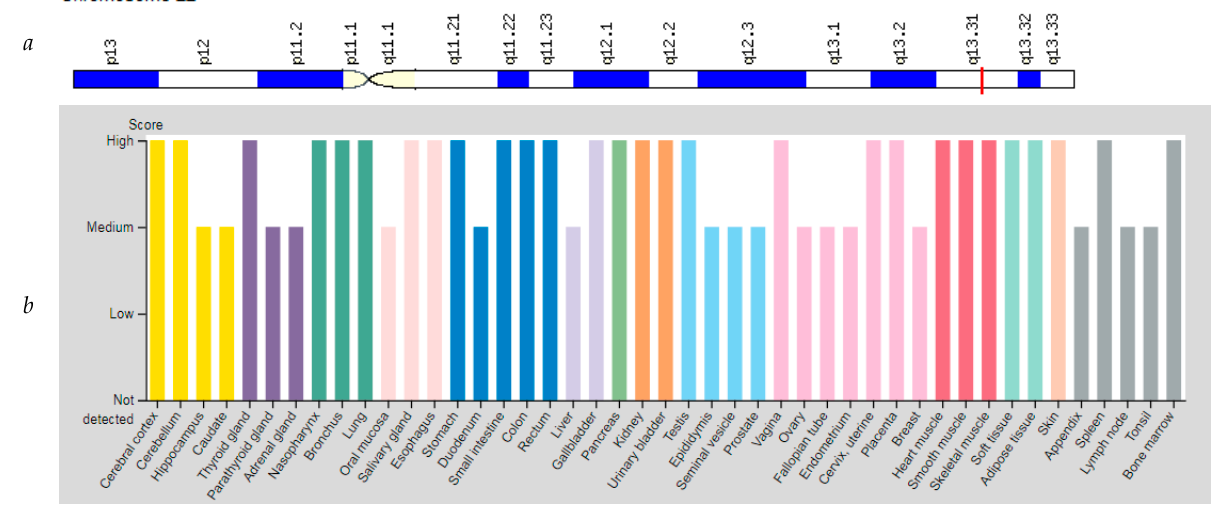
Figure 5. Location of the PPARA gene ( a ) and tissue expression of the peroxisome proliferator activated receptor Alpha ( b ). The most frequently analyzed SNV in this gene, G46630634C (rs4253778), is located in intron 7